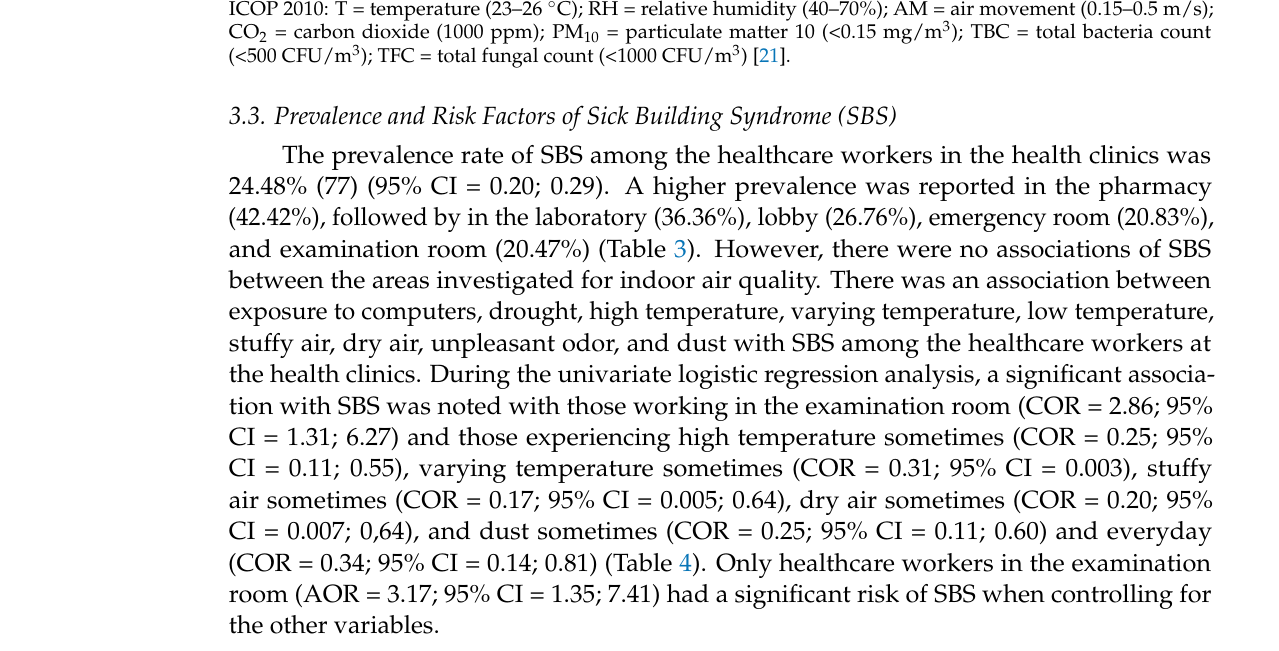
Table 3. Univariate analysis of SBS among healthcare workers in health